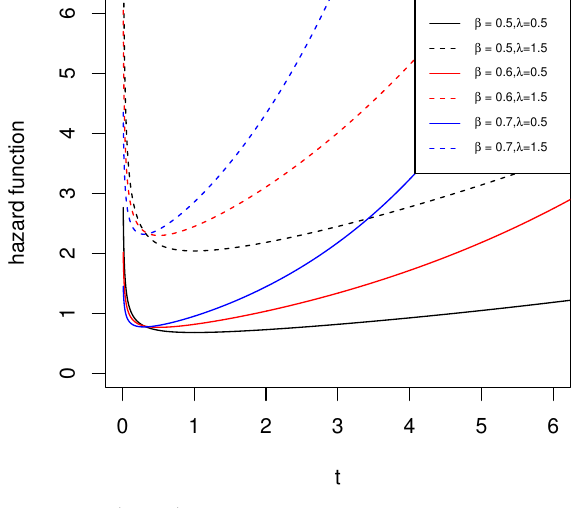
Figure 5. h ( t ; β , λ ) , 0 < β < 1.